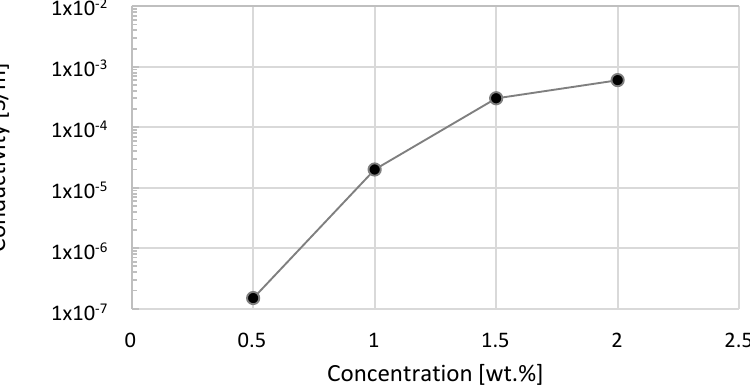
Figure 1. Plot of the dependence of carbon-black-weight percentage on the conductivity of the epoxy resin modified with it (source: own work on the basis of [34]).